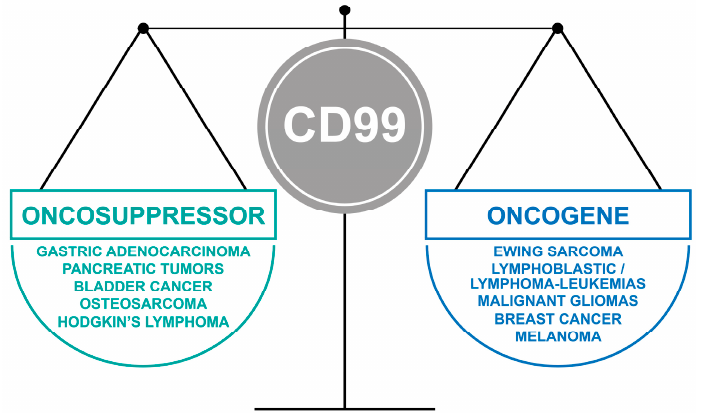
Figure 2. The oncojanus function of CD99 in tumors.